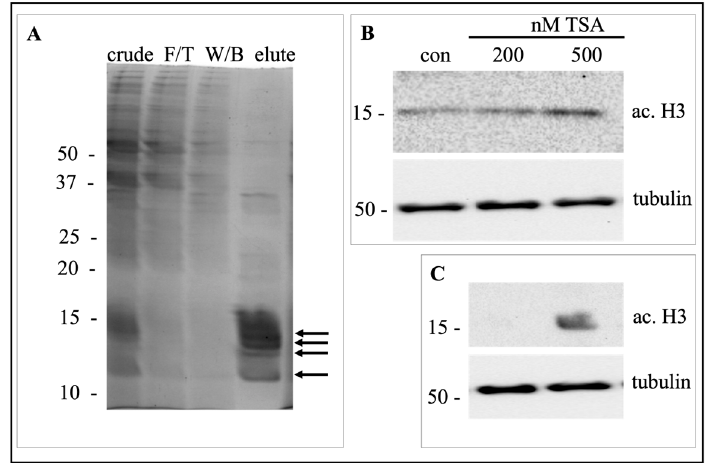
Figure 6. Native and acetylated histone puri fi cation. ( A ) Histones were extracted from a 100 mm tissue culture plate of WIF-B cells using histone puri fi cation mini kit. Crude histones, fl ow-through (F/T), wash bu ff er (W/B) and fi nal elute (lane 1 to lane 4) were collected and loaded onto 15% SDS-PAGE. The gel was stained with Coomassie blue to visualize protein bands. The arrows on the right indicate bands resembling the molecular weight of H3, H2A, H2B, and H4 from top to bo tt om. ( B ) WIF-B cells were grown in 1 cm × 1 cm coverslips and treated with 200 or 500 nM trichostatin A (TSA) for 30 min. The whole cell lysate was made in 500 μ L of Laemmli sample bu ff er. Ten μ L of the lysate was immunoblo tt ed for acetylated histone 3 (ac.H3) using Western blot. Tubulin was used as a loading control. ( C ) Ten μ g of histones puri fi ed from control or 500 nM TSA treated WIF-B cells grown on 100 mm tissue culture plate were immunoblo tt ed against ac.H3. The whole cell extract was immunoblo tt ed against tubulin to use as a loading control. The numbers on left represent the molecular weight in KDa of the protein standard.